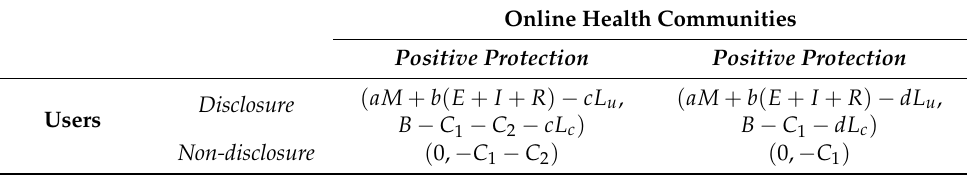
Figure 3. Relationship between online health communities and users in the game model.